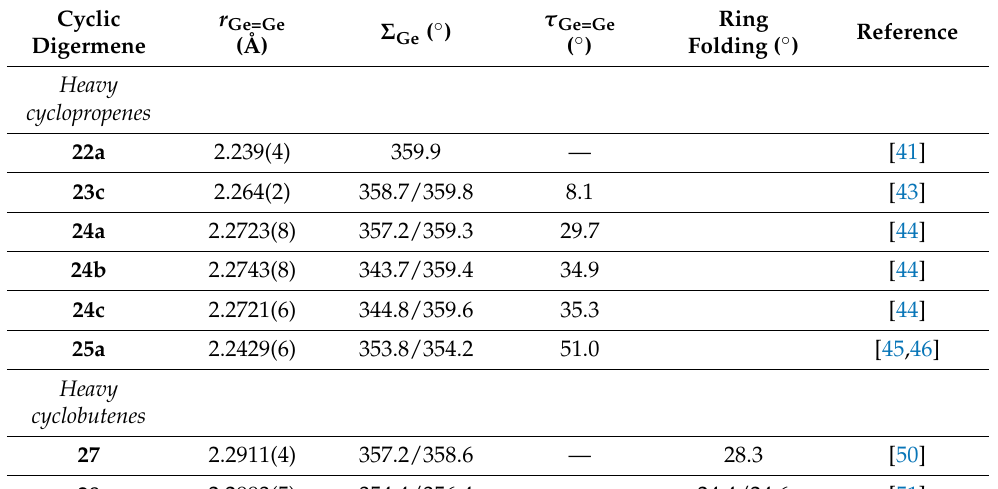
Ring Reference Folding ( ◦ )